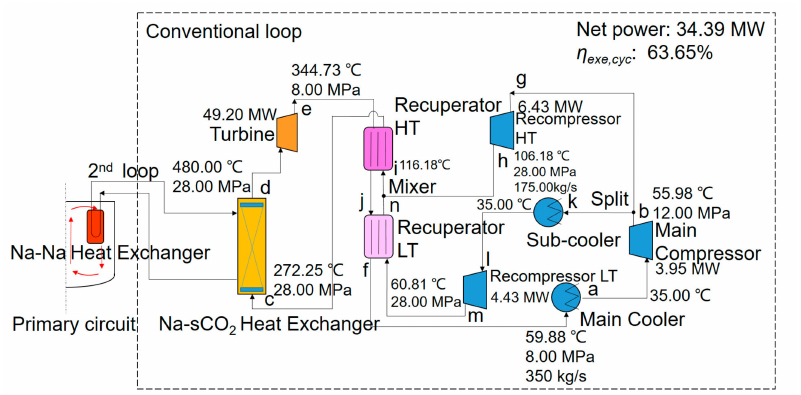
Figure 5. Optimal simulation results of the partial-cooling cycle with sCO 2 -SFR. a–n represent state points of working fluid in the